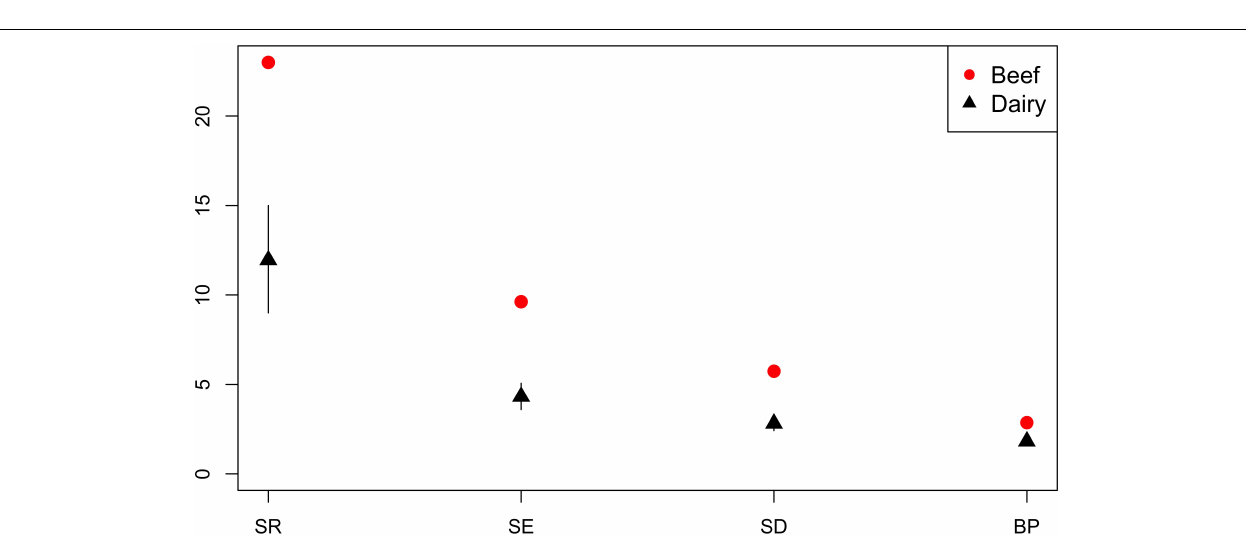
FIGURE 9 | Observed ecological diversities of phenotypic antimicrobial resistance profiles of S. Typhimurium isolates from beef and dairy